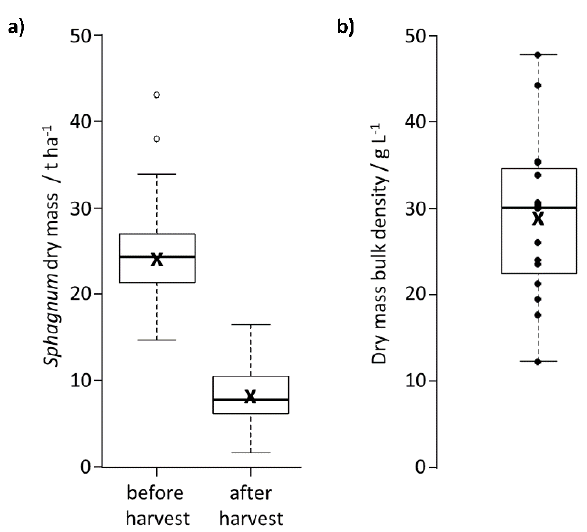
Figure 5. a) Sphagnum dry mass after five years of growth, before and remaining after harvest (each n = 30); and b) dry bulk density ( n = 16, cf. Table A2). The plot shows the median (bold line), the mean (x), the upper and lower quartiles (including 50 % of the data and creating the box), the whiskers representing the lowest and highest values still within 1.5 interquartile range (IQR) of the lower and upper quartile, respectively, and the outliers (o), i.e. the values outside these ranges.